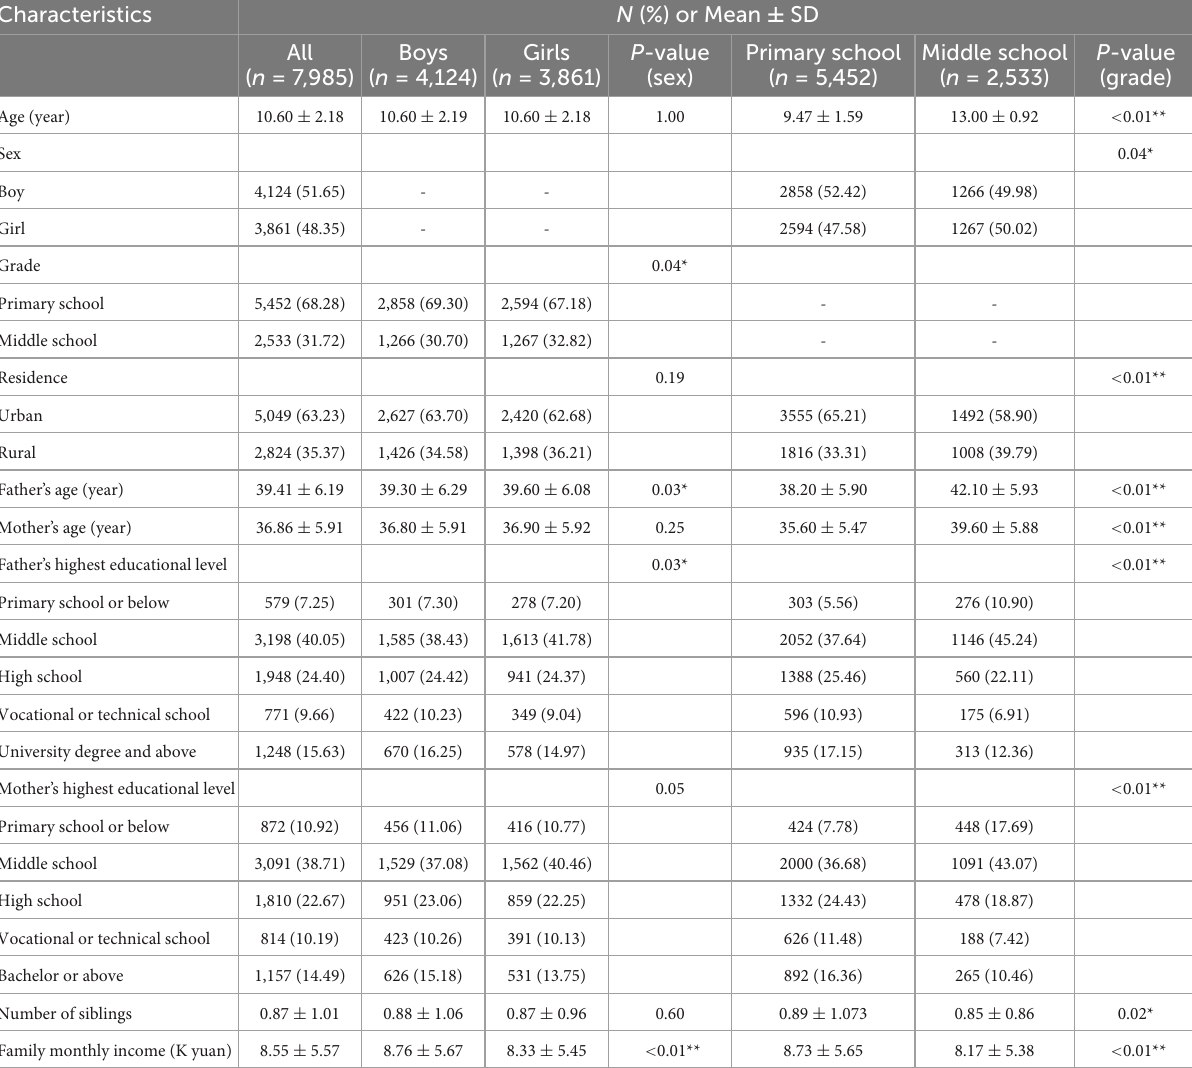
TABLE 1 Wave one characteristics of the two waves participants in Chengdu Survey of Positive Child Development (CPCD).